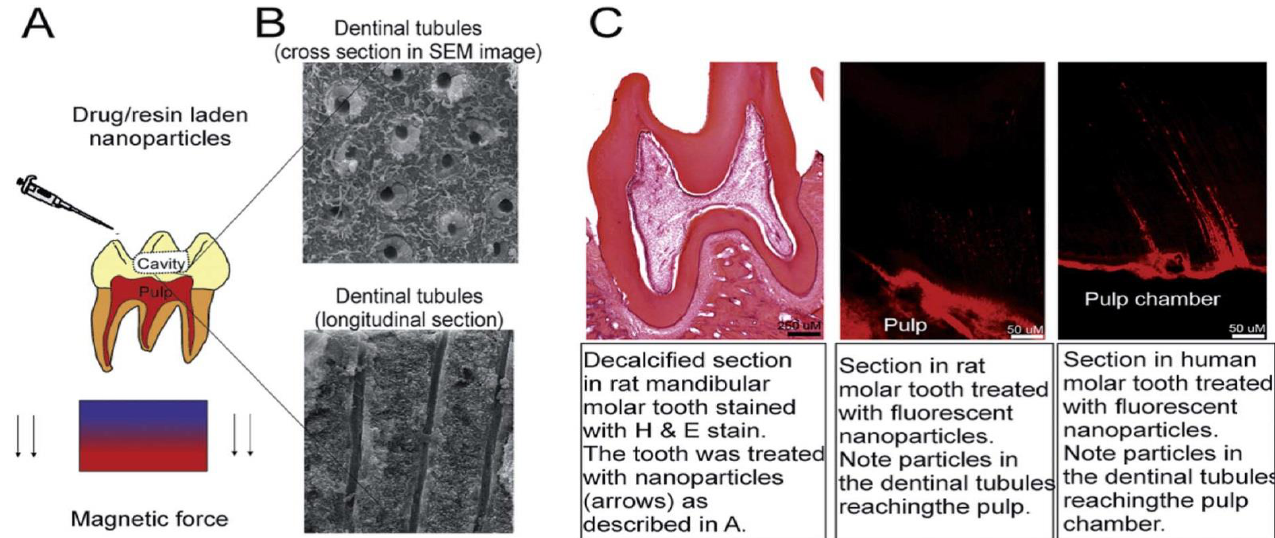
Figure 10. Description of the technology of conduction and delivery of drug-containing nanoparticles to the dental pulp. This technology exploits natural channels extending from the dentin to the pulp and magnetic force to deliver iron nanoparticles deep into the tooth structure. The technology was tested on rat molars and freshly extracted human teeth. It can be used to drug-load nanoparticles into the pulp or improve the bond strength of commercially available adhesive resins on the market in dentin ( A ) shows the surgery implantation of rhBMP-2 adsorbed MWCNT/CHI scaffolds into mouse subcutaneous muscular pocket. Optical microscope micrograph ( B ) shows regenerated bone tissue and a minor fraction of remaining MWCNT/CHI scaffold. Optical micrograph ( C ) shows a detail of regenerated bone tissue (collagen expressing cells, blue–green colored) after major disassembly of the MWCNT/CHI scaffold, surrounded by muscle tissue (pink colored). It is remarkable the well-limited interface between adjacent tissues (see black dash line). The remaining MWCNT/CHI scaffold (black colored) is pointed by black arrow